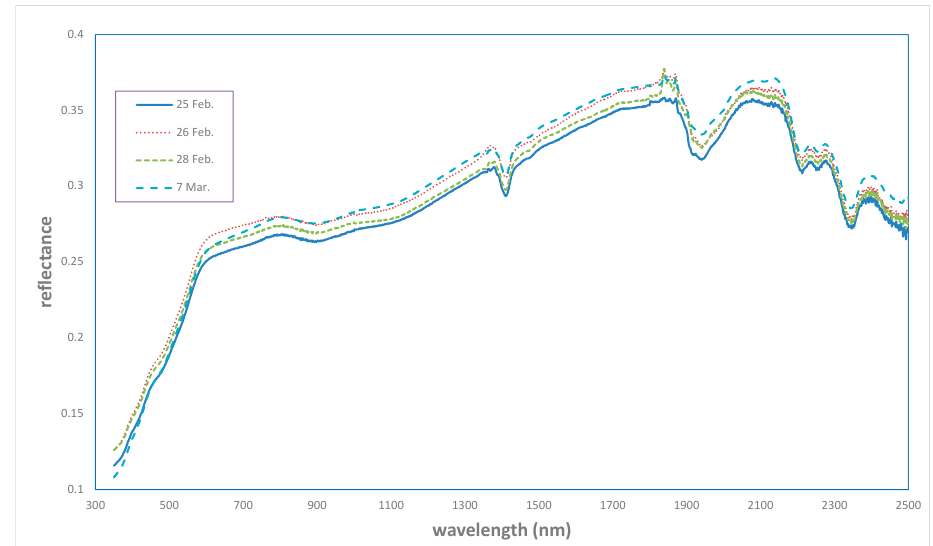
Figure 7. Ground reflectance at the Dunhuang calibration site on different dates. Measurements on 7 March and 28 February 2017 correspond to SPARK-01 and SPARK-02, respectively.